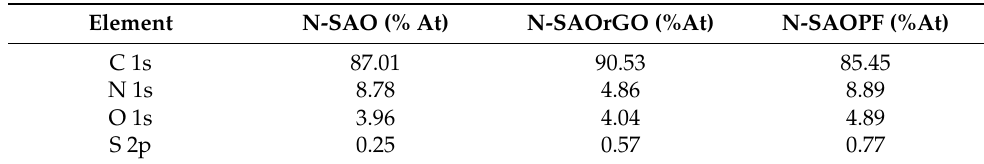
Table 1. Atomic concentrations of N-doped catalysts. Element N-SAO (% At) N-SAOrGO